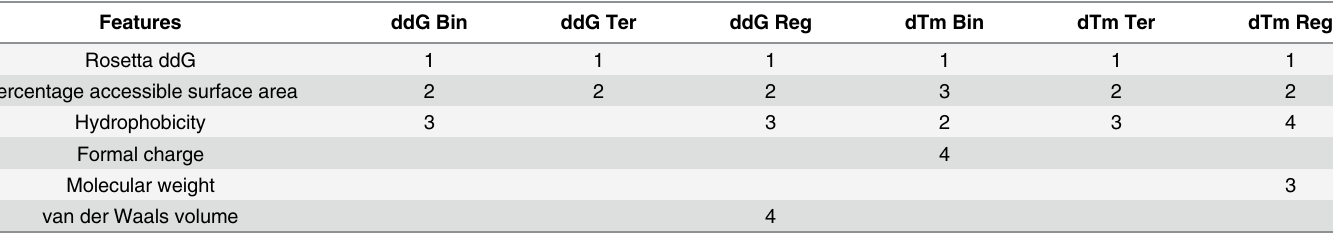
Table 9. Top ranked features (descriptors) which are selected by RFE. Numbers depict the importance ranking of the descriptors in each model. Features Rosetta ddG Percentage accessible surface